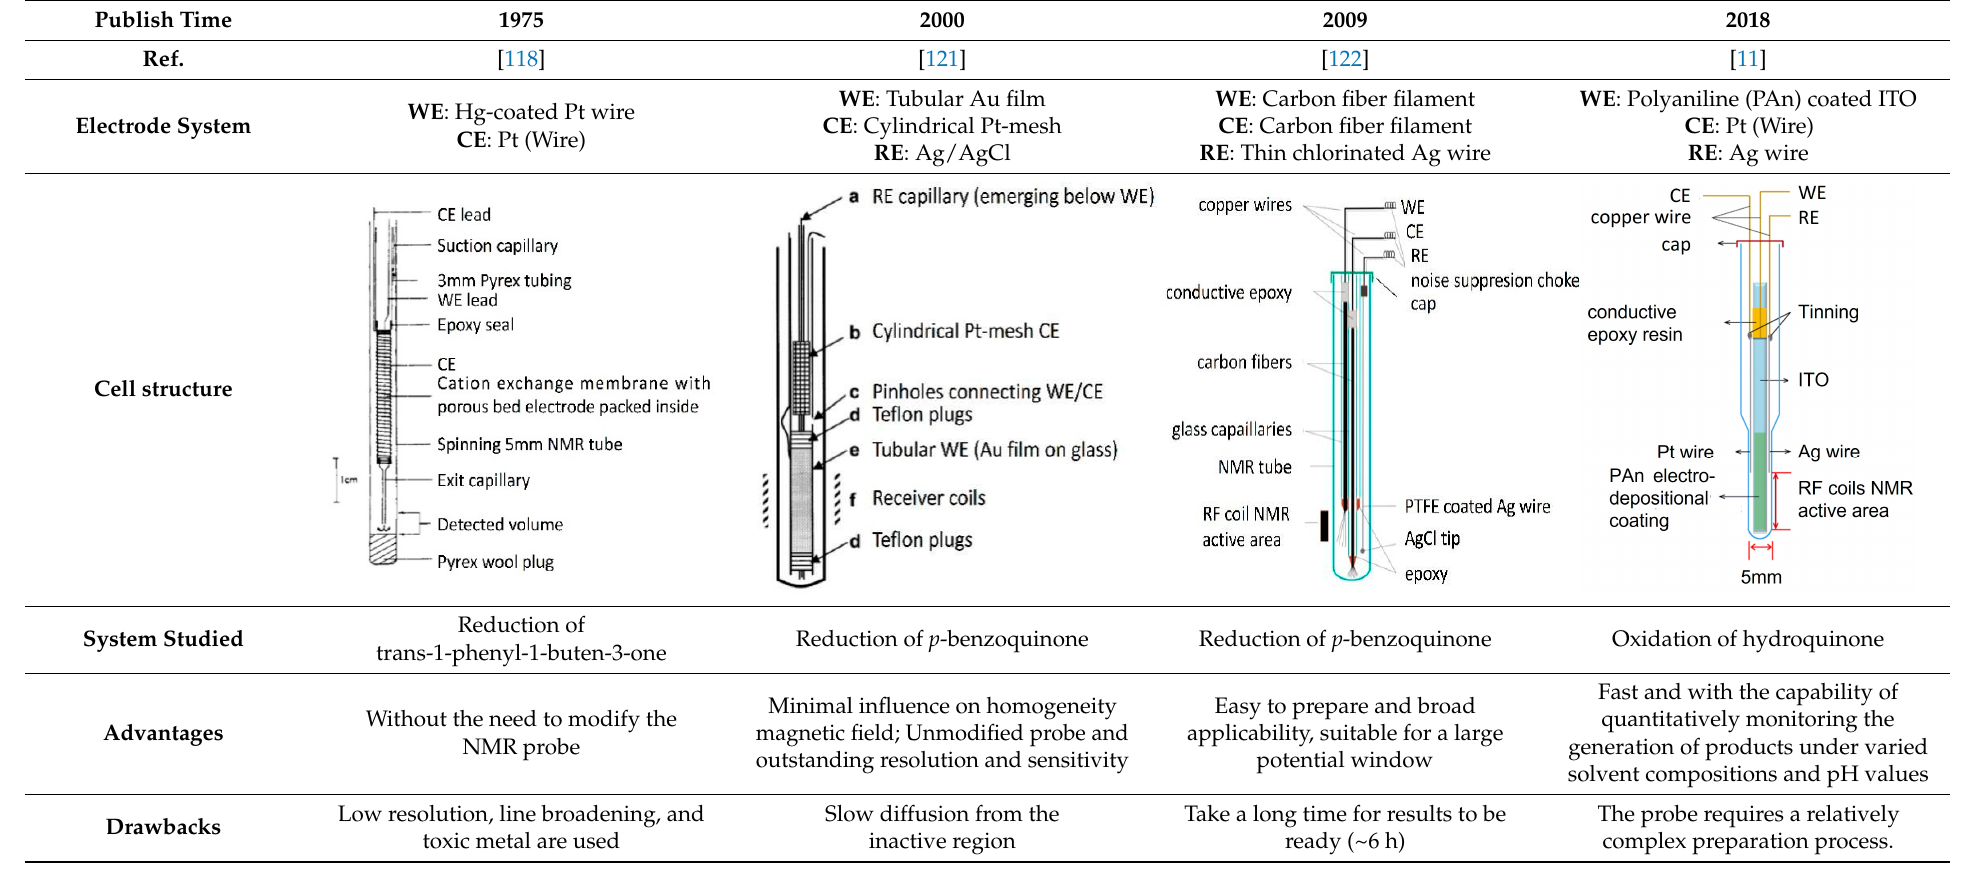
Table 3. A summary of NMR SEC’s development history.